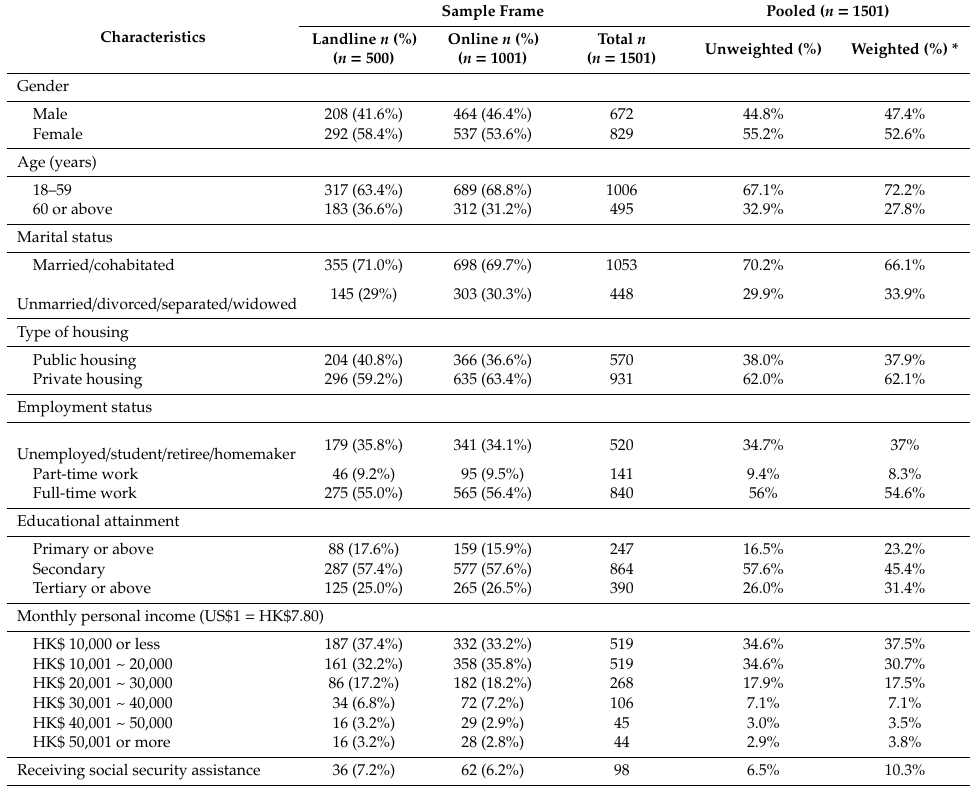
Table 1. Participant